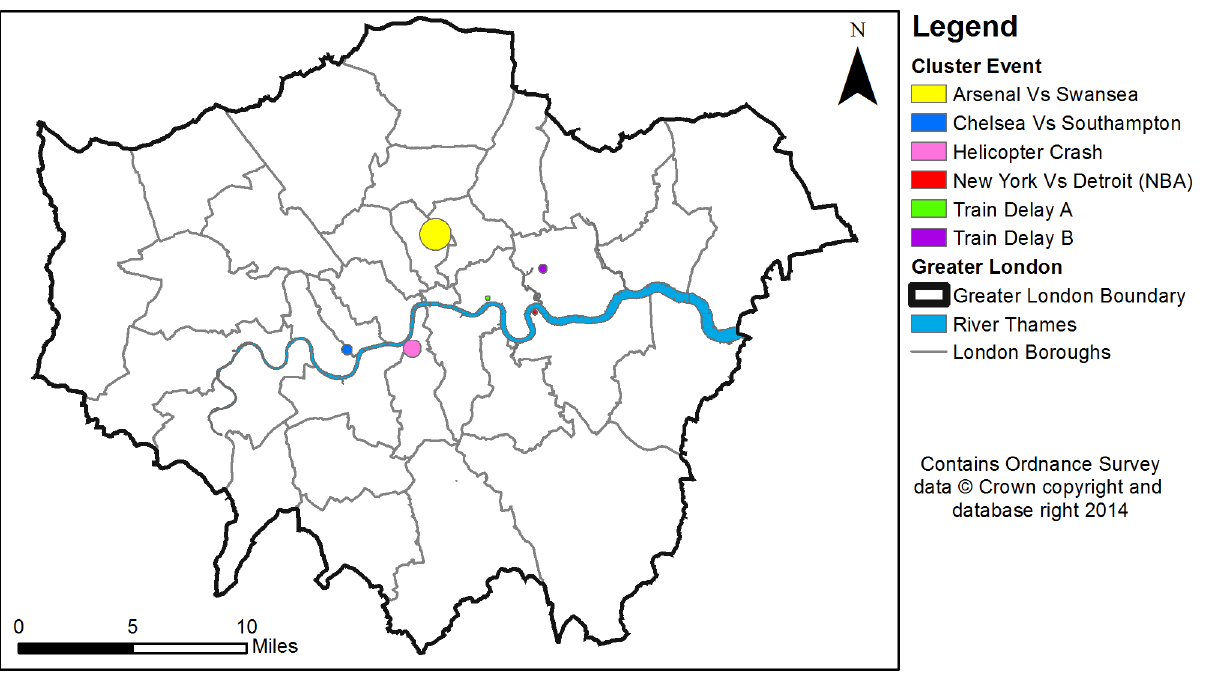
Figure 6. A top view of daily cluster events identified within London between 14th January and 18th January 2013.